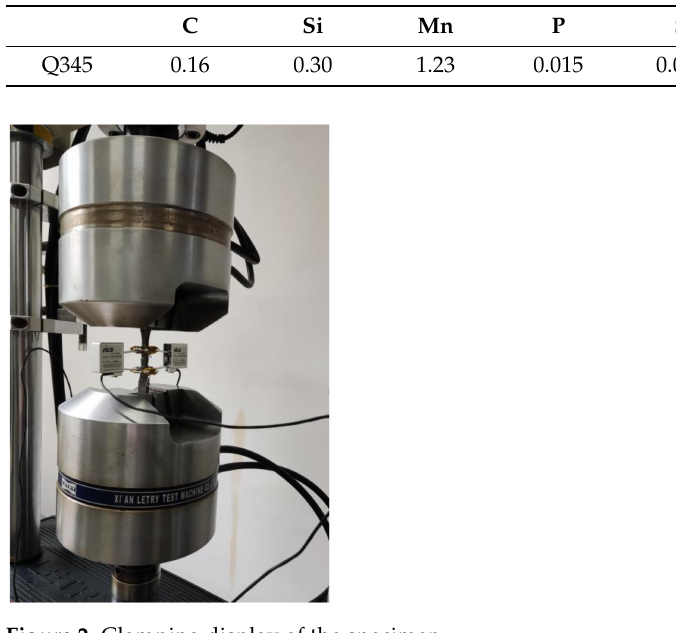
Figure 2. Clamping display of the specimen.